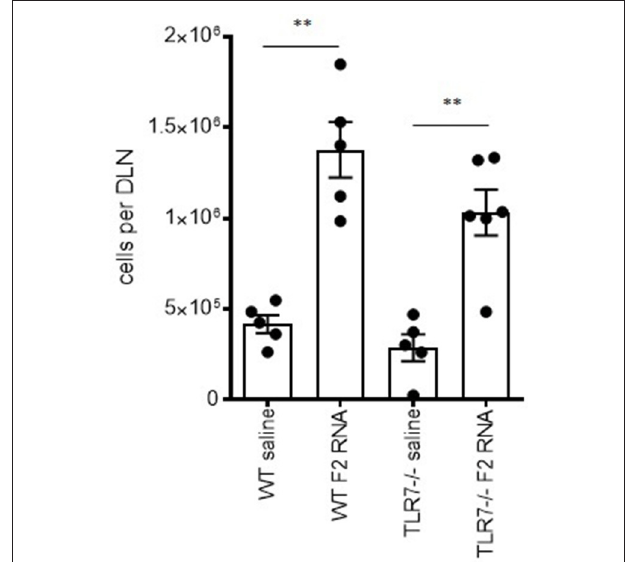
FIGURE 3 | Local immune activation following inoculation of RNA-F2 is not critically dependent upon TLR7. Wild type and TLR7–/– C57BL/6 mice were injected with 20 µ l vaccine into calf muscle. The RNA vaccine was prepared to provide a total of 10 µ g dose. Twenty-four hours after injection, the draining lymph node was excised and single cell suspensions prepared and enumerated. Each point depicts the data from a single animal, while the horizontal and vertical bars show the mean and SEM, respectively. Data are representative of results obtained in 2-3 independent experiments. ns, not significant and ** p -value < 0.01, respectively, when comparing the indicated group against the pertinent saline injected control group.